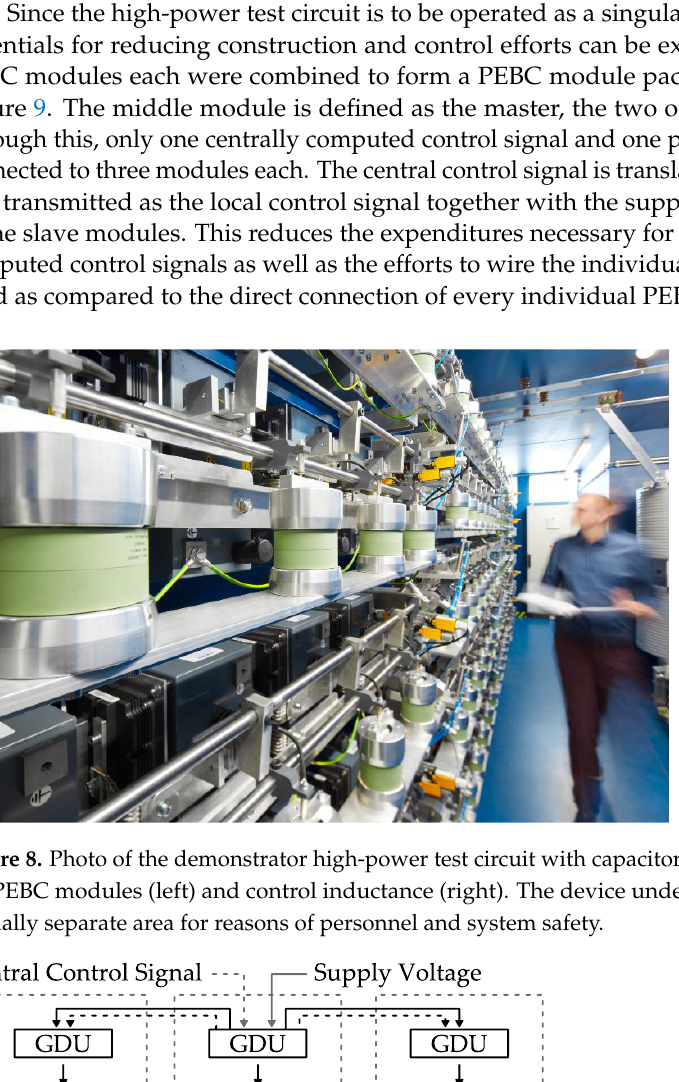
Figure 9. Schematic overview of the provision of central control signal (dashed) and power supply (continuous) infrastructure to a PEBC module package in master–slave configuration.